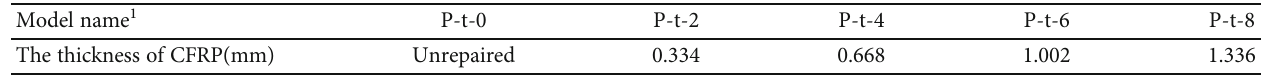
Figure 4: Strain comparisons between PCCP model and reference results. Table 3: The fi ve models.